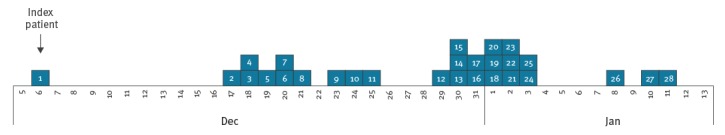
Confirmed cases of measles during the outbreak in the Gothenburg area, by date of symptom onset, Sweden, December 2017–January 2018 (n = 28)